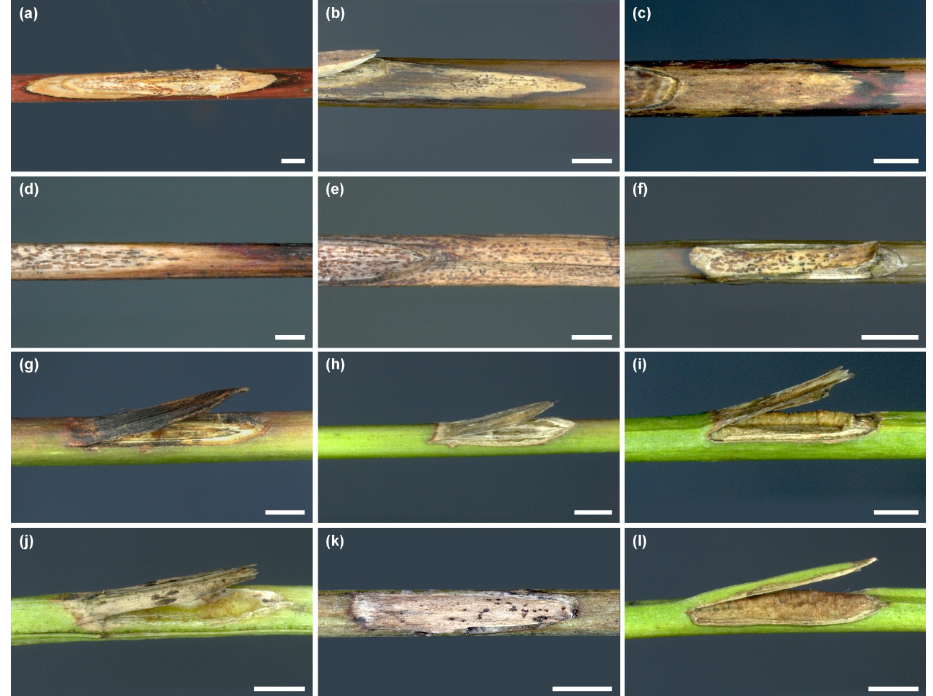
Figure 8. Occurrence of necrotic lesions on petioles of Acer pseudoplatanus and Fraxinus excelsior , eight weeks after wound inoculation with Apiognomonia hystrix . A. pseudoplatanus ( a – h ): extensive necrosis with light discoloration of necrotic tissues and with conidiomata of A. hystrix ( a – d ), petiole of fallen leaf with A. hystrix conidiomata covering the entire necrosis surface ( e ), inoculation wound covered with conidiomata, no tissue necrosis within the surrounding area ( f ), inoculation wound without developed conidiomata, no tissue necrosis within the surrounding area ( g ), control petiole without necrotic lesion ( h ); F. excelsior ( i – l ): partially closed wound with no discoloration of the sur- rounding tissue ( i ), wound without callus formation and no necrosis of the surrounding tissue, ma- ture conidiomata of A. hystrix on the inoculation wound ( j , k ), control petiole with fully closed wound ( l ); scale bars: ( a – l ) = 2 mm. None of the 48 inoculated F. excelsior petioles developed necrotic lesions (Table 4). On six of the petioles, the inoculation wounds healed completely, and an additional 27 of the petioles had partially healed the inoculation wounds (Figure 8i); no healing of the inoculation wounds was observed in 15 petioles (Figure 8j). Apiognomonia hystrix conidi- omata, within the incised petiole section, were observed on 8 F. excelsior petioles at the evaluation date, resulting in light-beige discolouration of the dead tissues (Figure 8j,k). According to the Mann–Whitney U test, the host origin of the isolates did not differ- entiate them with regard to the ability to cause necroses on petioles of the studied tree